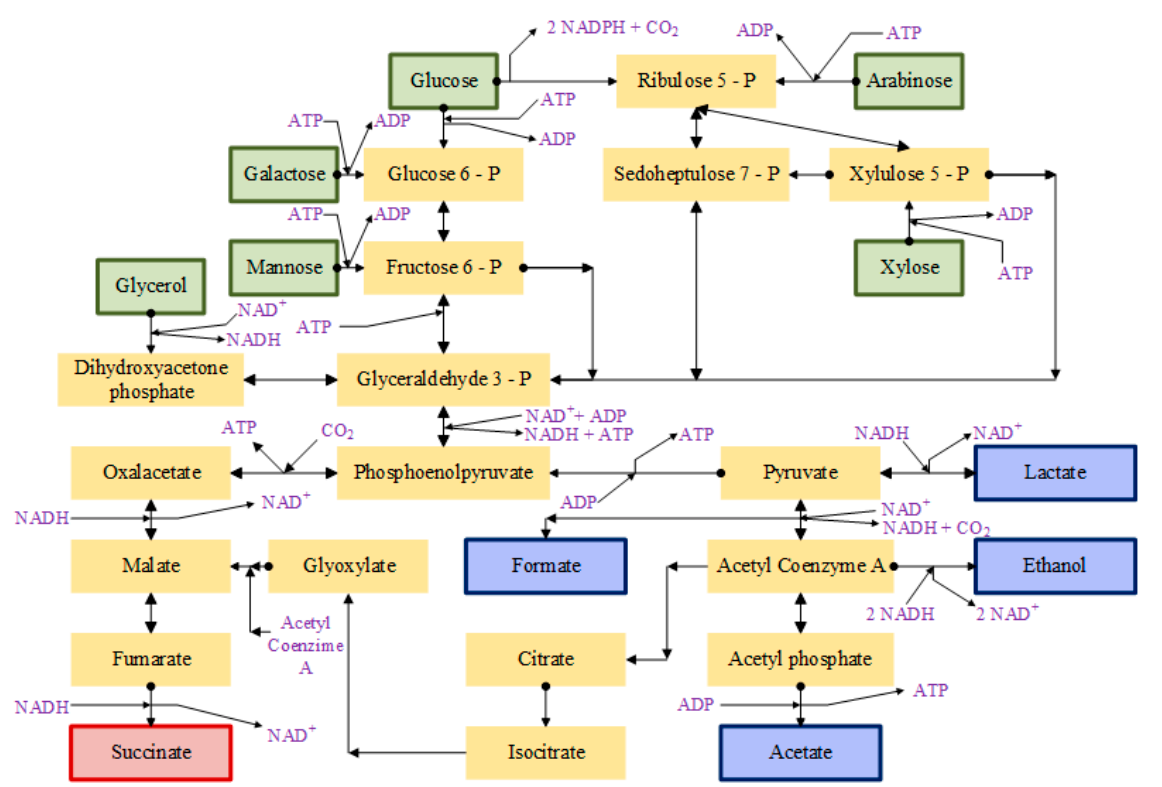
Figure 2. Metabolic pathways in succinic acid-producing microorganisms such as A. succinogenes , A. succinoproducens , M. succiniproducens and anaerobic succinate engineered E. coli. [26,28,29], Adenosine triphosphate (ATP), flavin adenine dinucleotide (FAD + ), nicotinamide adenine dinucleotide (NAD + ), reduced nicotinamide adenine dinucleotide (NADH), and reduced nicotinamide adenine dinucleotide phosphate (NADPH).